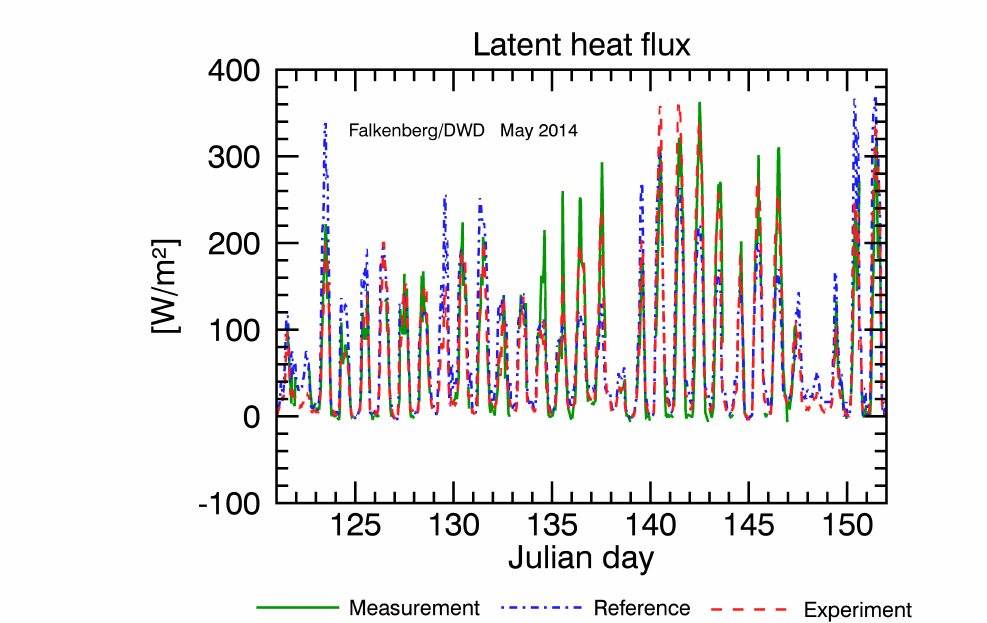
Figure 7. Same as Figure 3 but for May